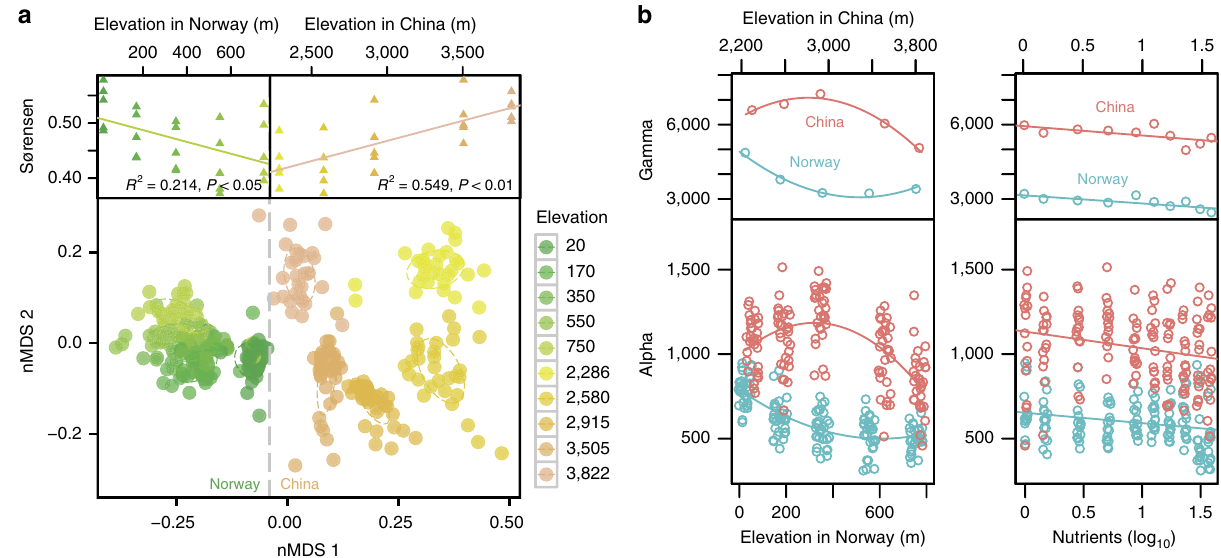
Figure 2 | Responses of community composition and diversity to elevation and nutrients. ( a ) Non-metric multidimensional scaling (nMDS) plot of bacterial communities (lower panel), grouped by elevation (m a.s.l., indicated by colour, with higher elevations in warmer colours) and country (indicated by dotted grey line). This plot illustrates that the communities at lower elevations in Norway (or higher elevations in China) were more similar to communities in China (or Norway) than the communities at higher elevations in Norway (or lower elevations in China), which is quantitatively supported by the upper figure panels (left: Norway; right: China) that have triangle points and linear regression lines. We calculated the community Sørensen similarity along the elevational gradient between each elevation of one region (that is, China) and all elevations of the other region (that is, Norway). The relationship between the similarity and elevation was fit and tested with a linear model and permutation tests in the R package lmPerm (v.1.1-2). ( b ) Gamma diversity (upper panels) and alpha diversity (lower panels) along elevations (left panels) and nutrient enrichment levels (right panels). For diversity-elevation and diversity-nutrient relationships, we applied quadratic and linear models, respectively, and significances of the relationships were examined with F-statistics. For gamma diversity-elevation relationships in Norway and China, the adjusted R 2 values were 0.952 ( P ¼ 0.024) and 0.957 ( P ¼ 0.022), respectively. For alpha diversity- elevation relationships in Norway and China, the adjusted R 2 values were 0.518 ( P o 0.001) and 0.335 ( P o 0.001), respectively. For gamma diversity-nutrient relationships in Norway and China, the adjusted R 2 values were 0.546 ( P ¼ 0.009) and 0.332 ( P ¼ 0.047), respectively. For alpha diversity-nutrient relationships in Norway and China, the adjusted R 2 values were 0.047 ( P ¼ 0.005) and 0.049 ( P ¼ 0.004), respectively. The elevations (m a.s.l.) in Norway (blue) and China (red) are shown along the bottom and top axes ( b , left panels), respectively. The amount of NO 3 (cid:3) (mg N l (cid:3) 1 ) initially added to the microcosms represents the nutrient enrichment ( b , right panels). The points were jittered for better visualization ( b , lower